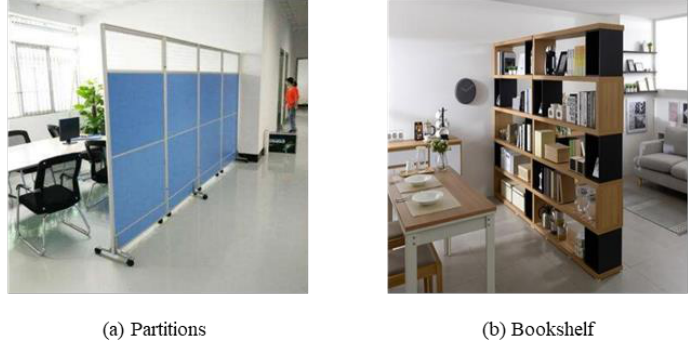
Figure 3. Vertical division components.